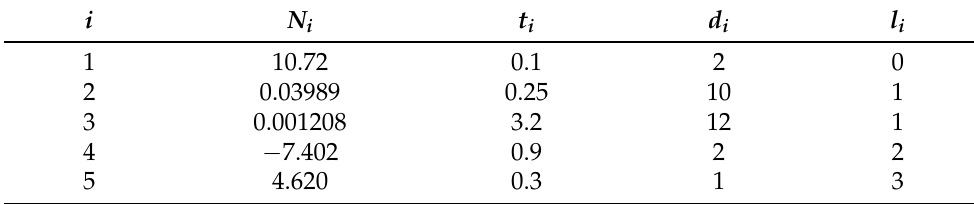
Table 3. Nitrogen coefficients and exponents of the residual fluid viscosity equations